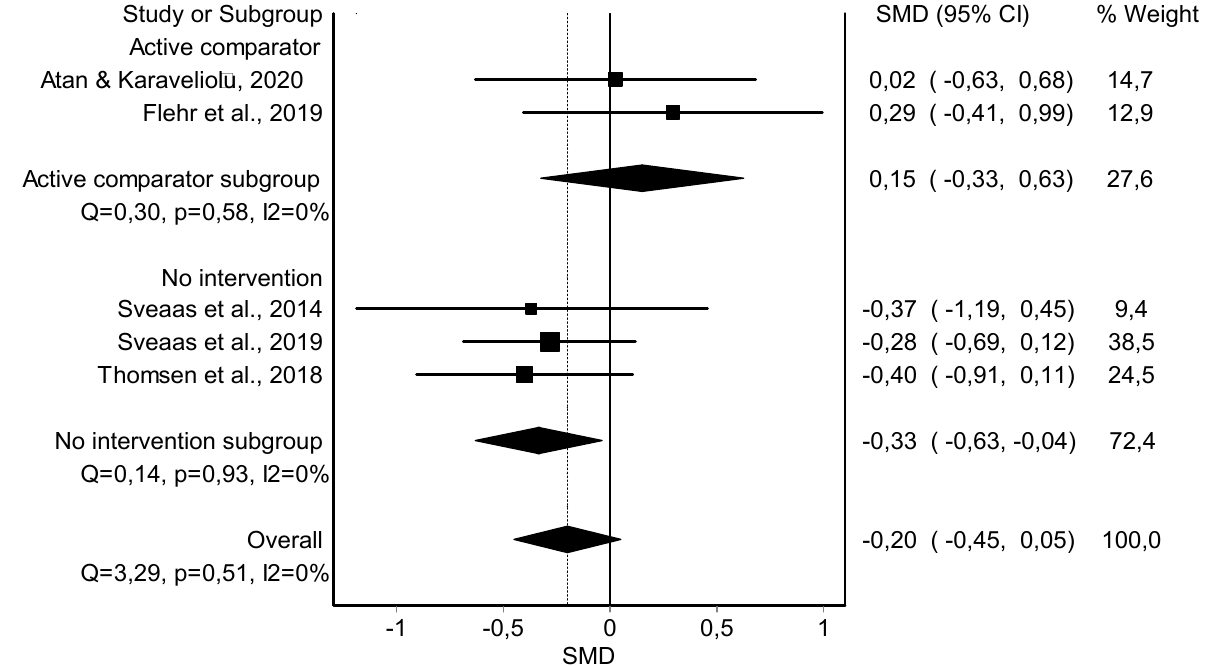
Figure 1. Synthesis forest plot of resting heart rate variable. If the diagram (diamond-shaped) is in the negative zone (on the left of the figure and without touching the 0 line), it indicates statistically significant differences in favor of the HIIT intervention. The forest plot summarizes the results of included studies (standardized mean differences [SMDs], and weight). The small boxes with squares represent the point estimate of the effect size and sample size. The lines on either side of the box represent a 95% confidence interval (CI).